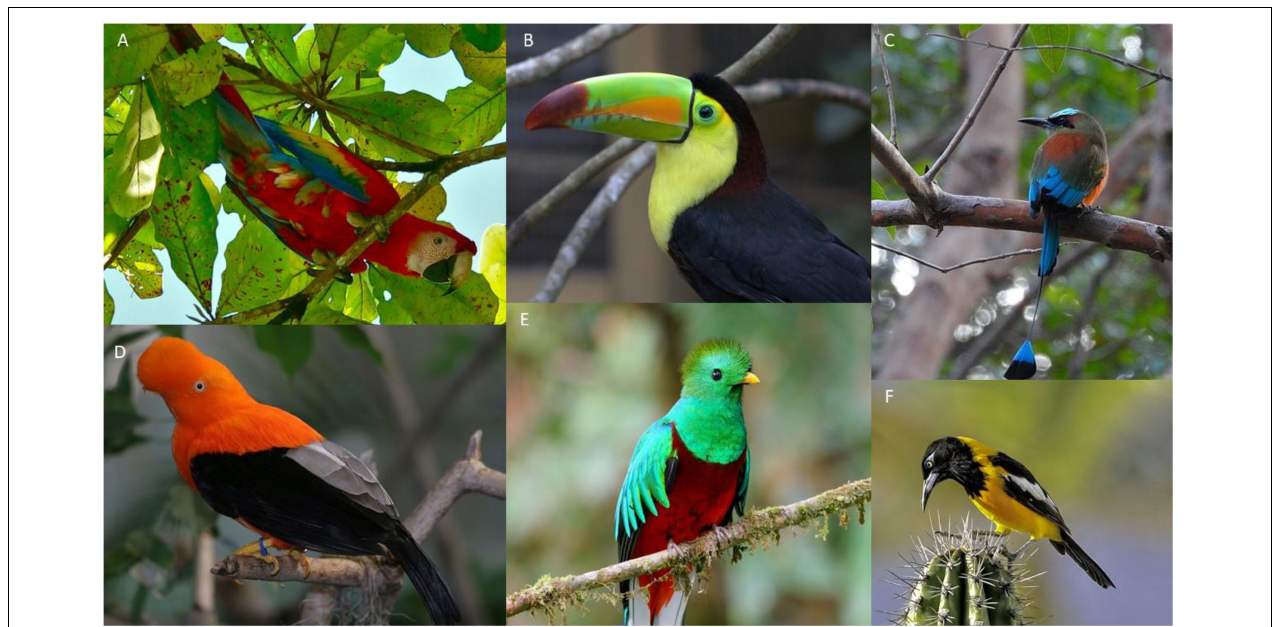
FIGURE 6 | National birds of South American countries. Clockwise from the left: (A) Scarlet Macaw ( Ara macao ), the national bird of Honduras, by Bernard Dupont in Puerto Jimenez, Costa Rica. (B) Keel-billed toucan ( Ramphastos sulfuratus ), the national bird of Belize, by Lauri Vain at Macaw Mountain Bird Park and Nature Reserve, Honduras. (C) Turquoise browed motmot ( Eumomota superciliosa ), the national bird of Nicaragua and El Salvador, by Asa Berndtsson in Costa Rica. (D) Andean cock-of-the-rock ( Rupicola peruviana ), the national bird of Peru, by Jerry Thomspon at San Diego Zoo, United States. (E) Resplendent Quetzal ( Pharomachrus mocinno ), the national bird of Guatemala, by Cephas in Monteverde, Costa Rica. (F) Venezuelan Troupial ( Icterus icterus ), the national bird of Venezuela by Betty Wills at Bonaire, Venezuela.